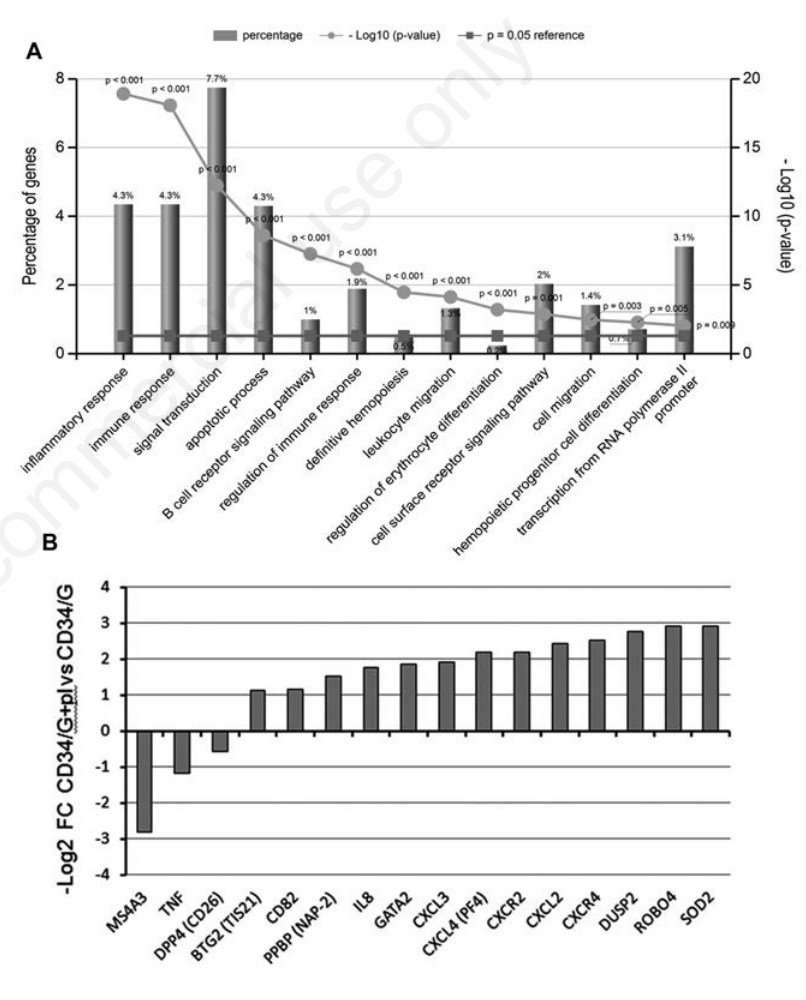
Figure 1. Bar graph representations of the differential expression profiles of genes that were analysed in the microarray analysis. A) Bar graph of biological process overrepre- sented in CD34/G+pl cells compared to CD34/G cells. B) Log changes are shown to rep- resent the difference in the expression level of genes differentially expressed between CD34/G+pl cells and CD34/G cells. -Log2-fold changes (FC) were calculated after nor- malization to Universal Reference RNA (P<0.01, FC cut-off ±2). Values greater than or equal to 1 represent gene up-regulation, and values less than 1 indicate gene down-regu-